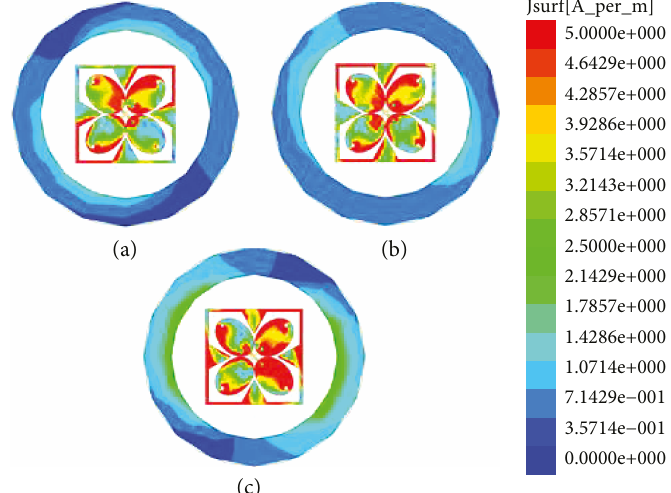
Figure 5: Simulated current distributions at (a) 1.0GHz, (b) 1.4GHz, and (c)